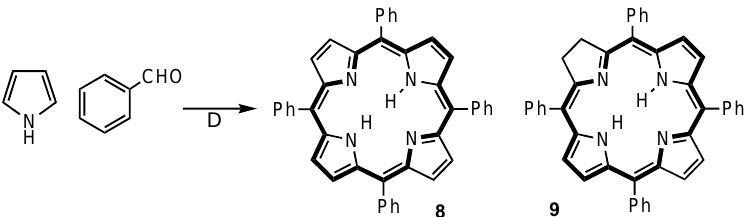
Molecules 2023 , 28 , x FOR PEER REVIEW Scheme 1. Rothemund synthesis of meso -tetraphenylporphyrin and a chlorin byproduct.